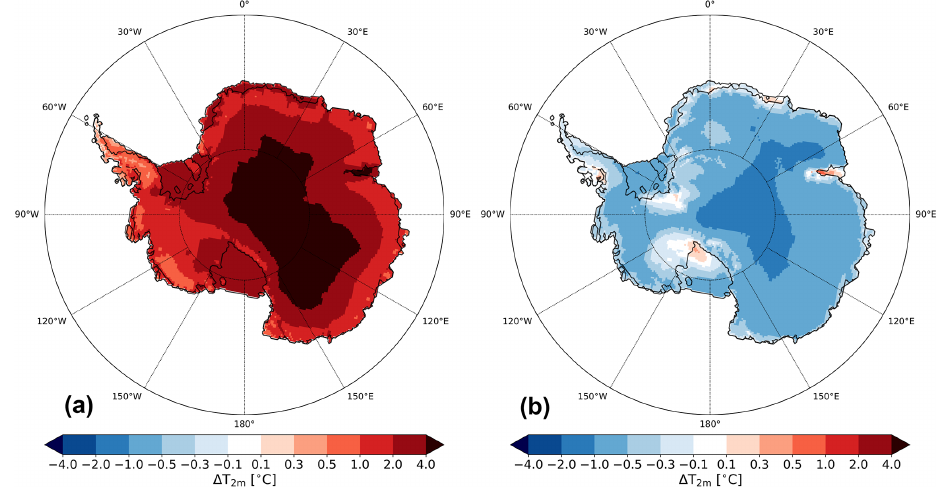
Figure A1. Summer mean monthly-averaged 2m temperature ( T 2m ) difference with Rp2 for (a) GS and (b) CON for 1985–2018, with positive values indicating a temperature increase with respect to